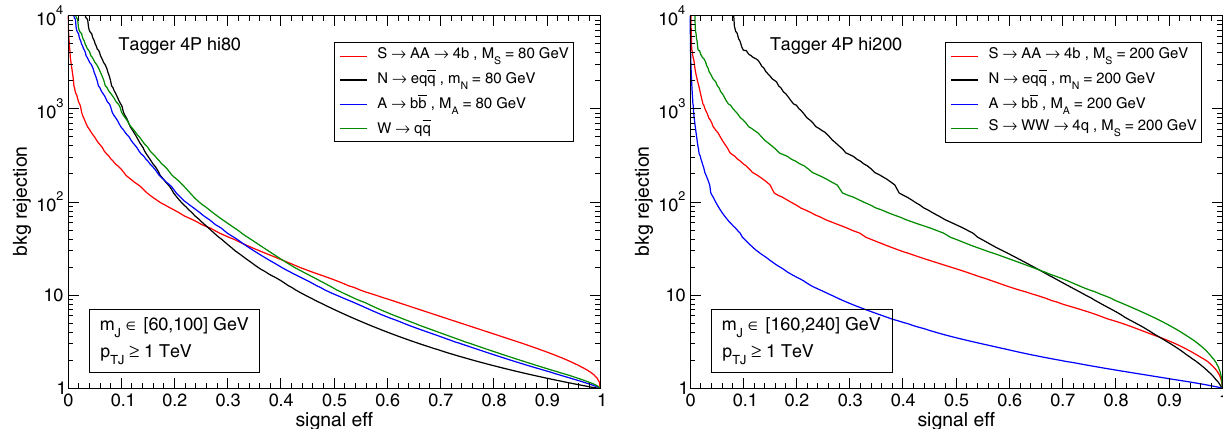
for hi200 . These examples highlight the benefit of the mass decorrelation even if it is not perfect, see Fig. 1. A drawback of the decorrelation procedure is a slightly worse discrimi- nation between signal and background, as it can be seen in Fig. 10, for four-pronged (left), three-pronged (middle) and two-pronged (right) taggers, designed in the same kinemati- cal region hi80